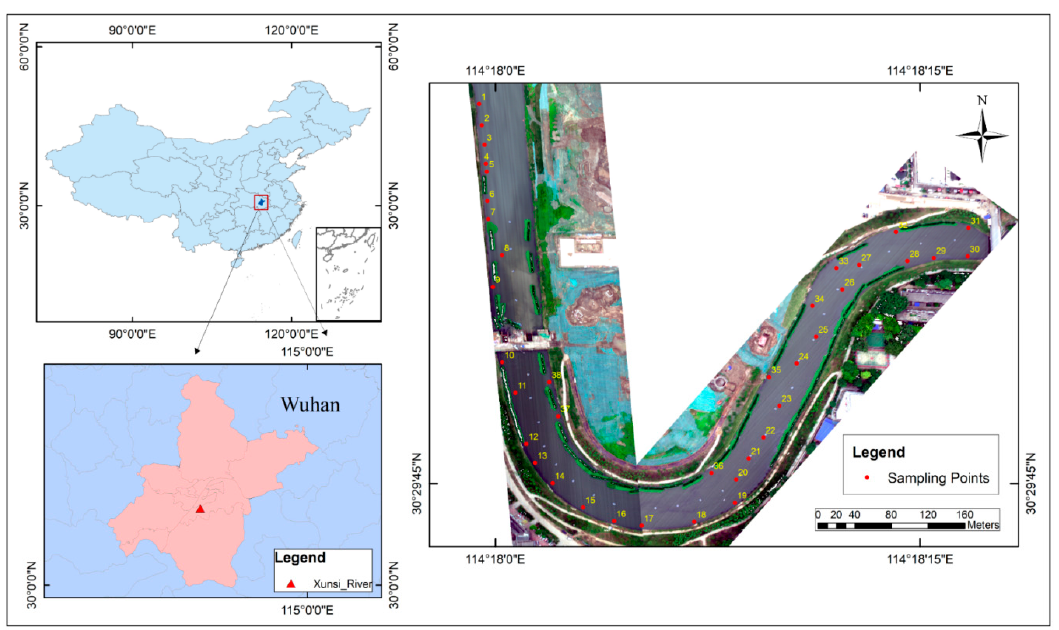
Figure 2. Sampling stations in the Xunsi River.